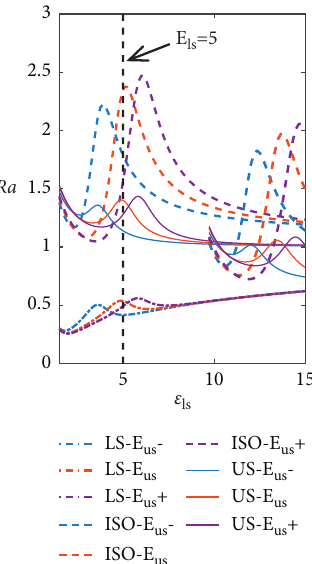
Figure 13: RMS ratios Ra with various ε